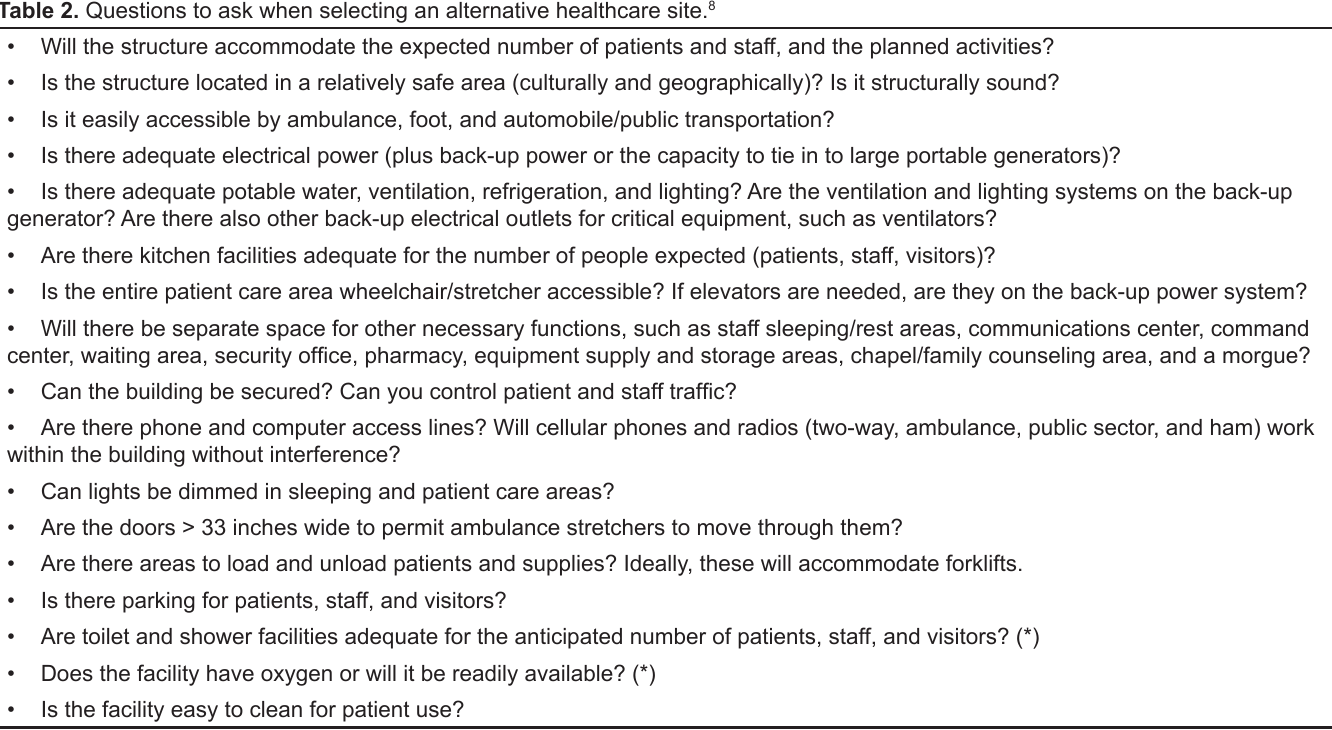
Table 2. Questions to ask when selecting an alternative healthcare site. 8